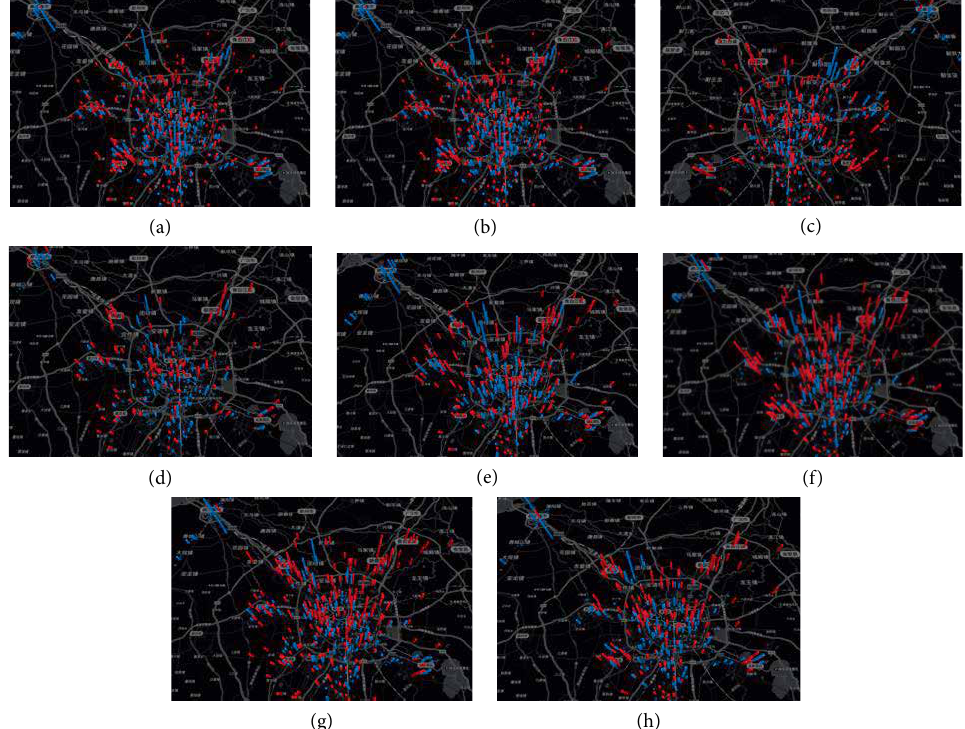
Figure 13: Predicted drop-off demand distribution on map during different time periods. (a) 00:00–07:00. (b) 07:00–09:00. (c) 09:00–12:00.